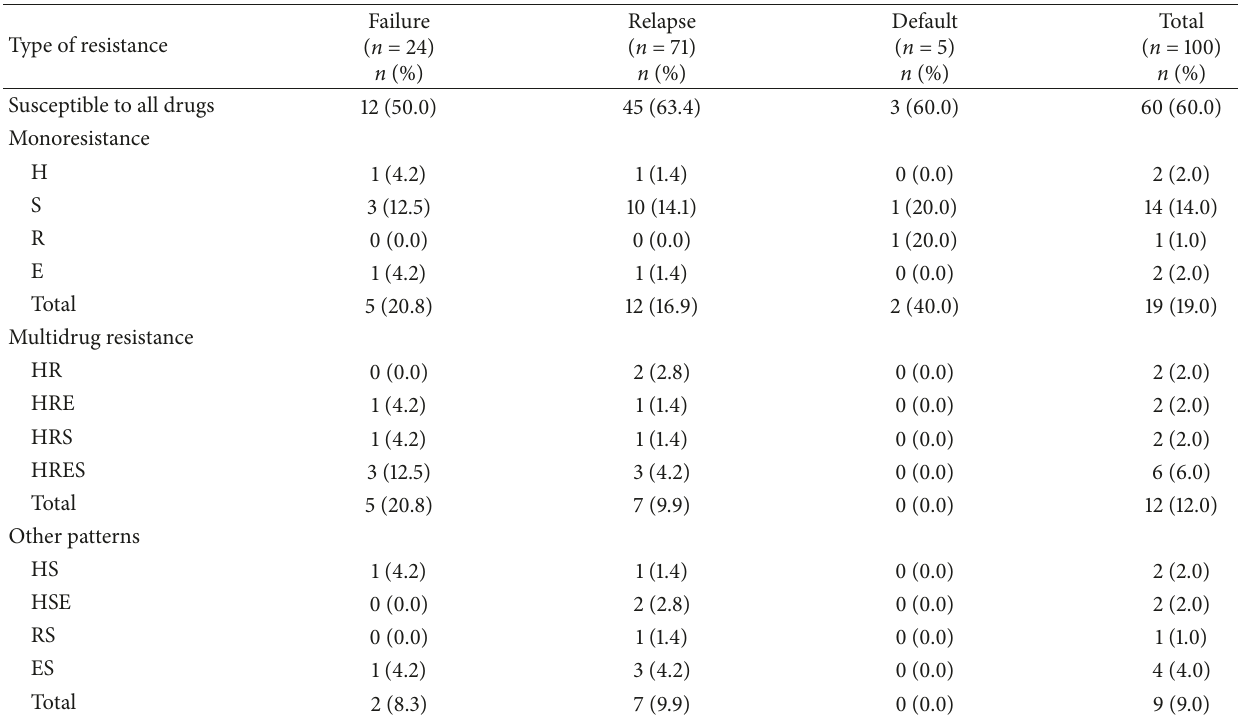
Table 1: Resistance pattern of strains to first-line drugs.